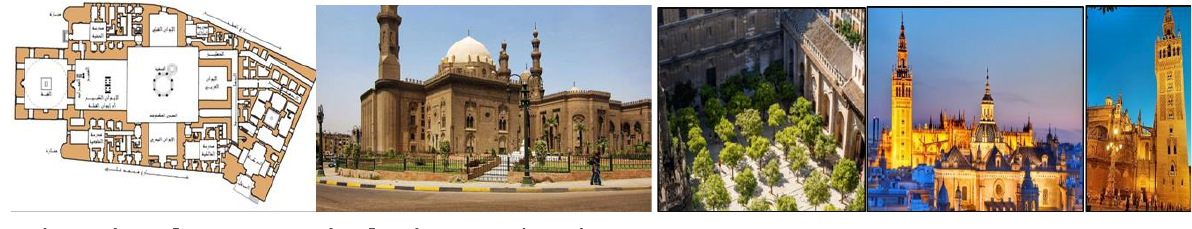
Fig. 5. Seville Mosque in Spain Source.